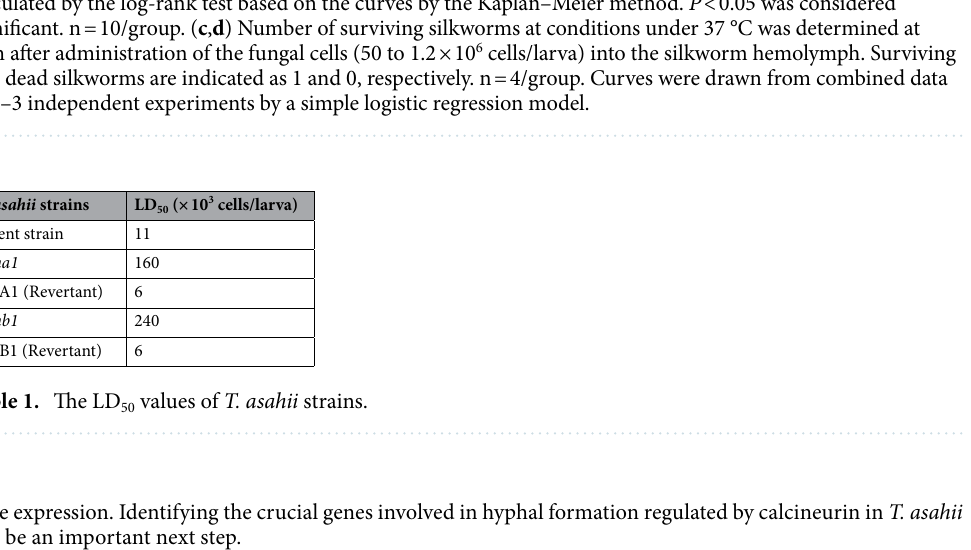
gene expression. Identifying the crucial genes involved in hyphal formation regulated by calcineurin in T. asahii will be an important next step. Tacrolimus (FK506), a calcineurin inhibitor, affects the physiologies of several pathogenic fungi 41,42 . On the other hand, FK506 suppresses the immune system by blocking T-cell activation in human 43 . Therefore, the immunosuppressive effect should be eliminated when used as a treatment for fungal infections. Juvvadi and colleagues succeeded to develop the low immunosuppressive FK506 analog APX879 that inhibits the Aspergillus